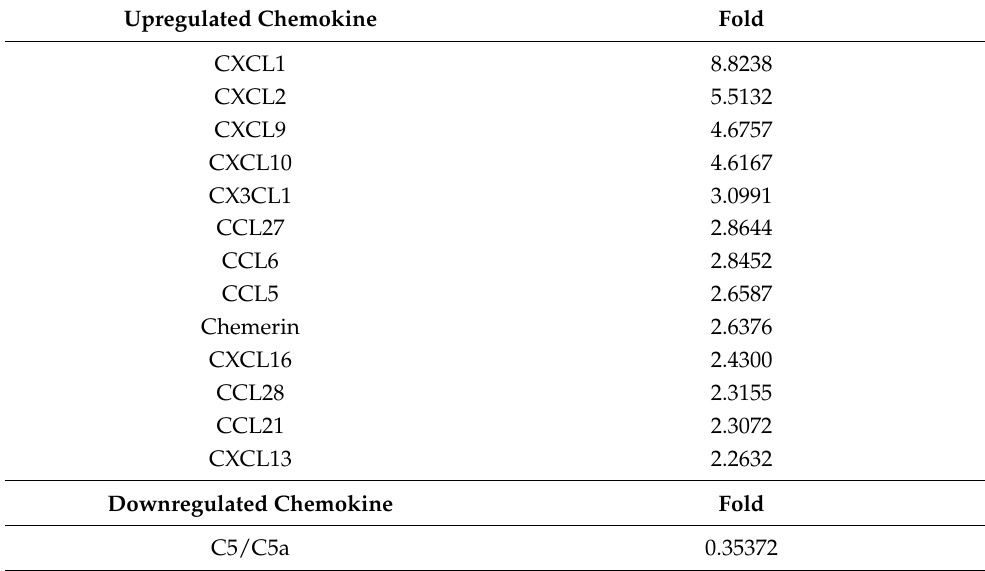
Table 2. A summary of the upregulated chemokines with fold change >2 and the downregulated chemokine from the mouse chemokine array. OMV-treated MHS were compared to EXO-treated MHS and CXCL1 was the most up-regulated chemokine ( n = 2). Upregulated Chemokine Fold